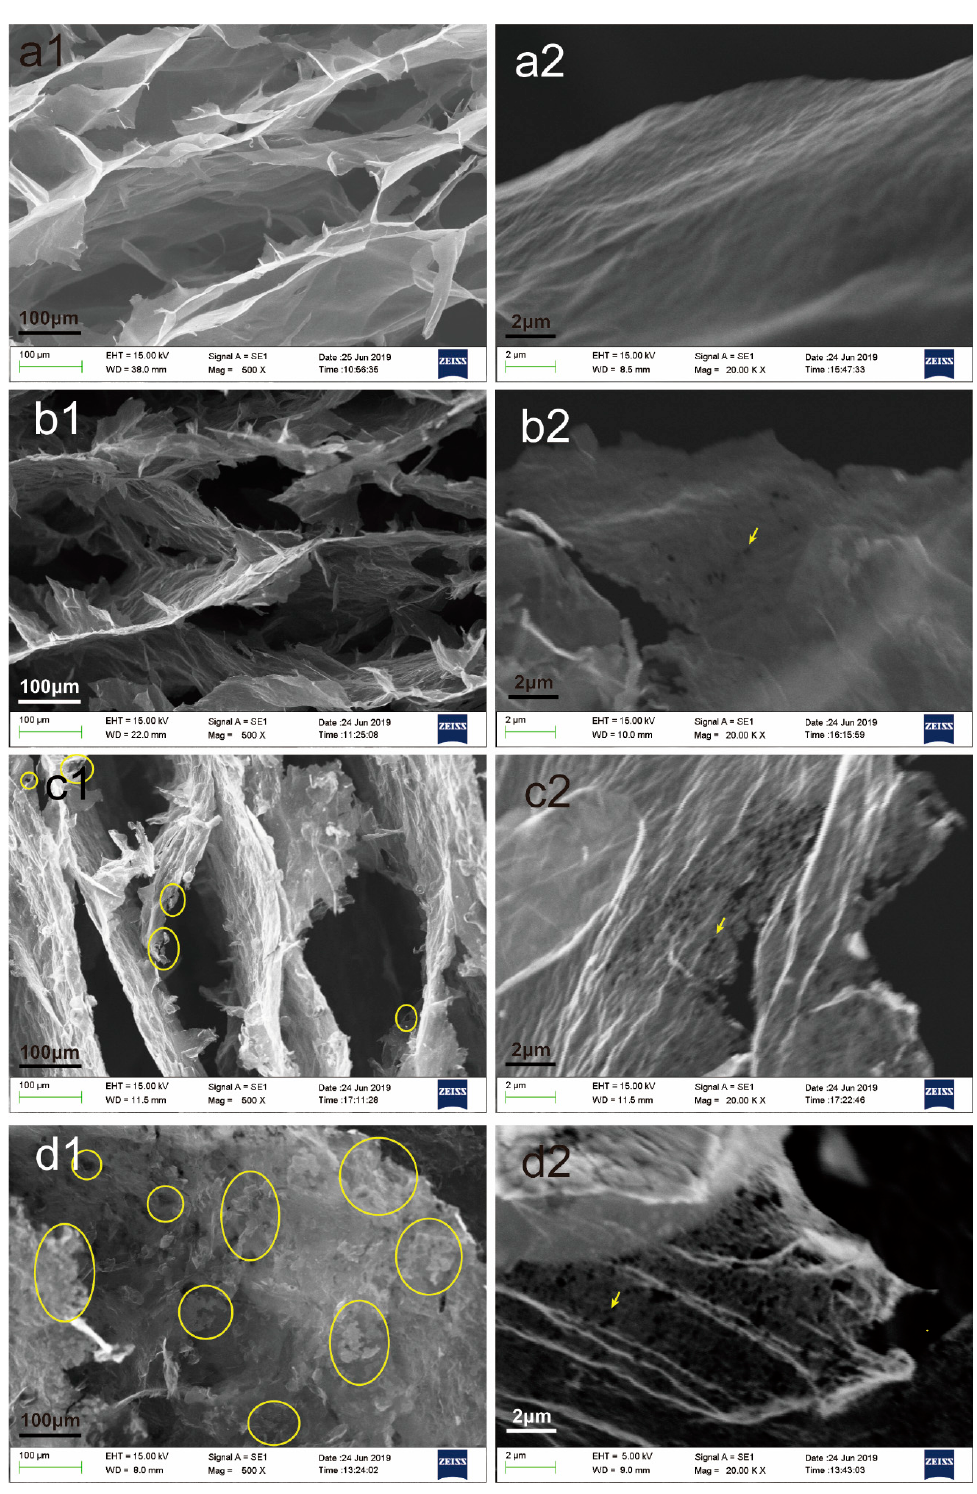
Figure 3. SEM images of graphene sheets in AGA with different microwave treatment times (( a1 , a2 ) were unmicrowaved, ( b1 , b2 ) were microwaved for 1 min, ( c1 , c2 ) were microwaved for 5 min, ( d1 , d2 ) were microwaved for 20 min).